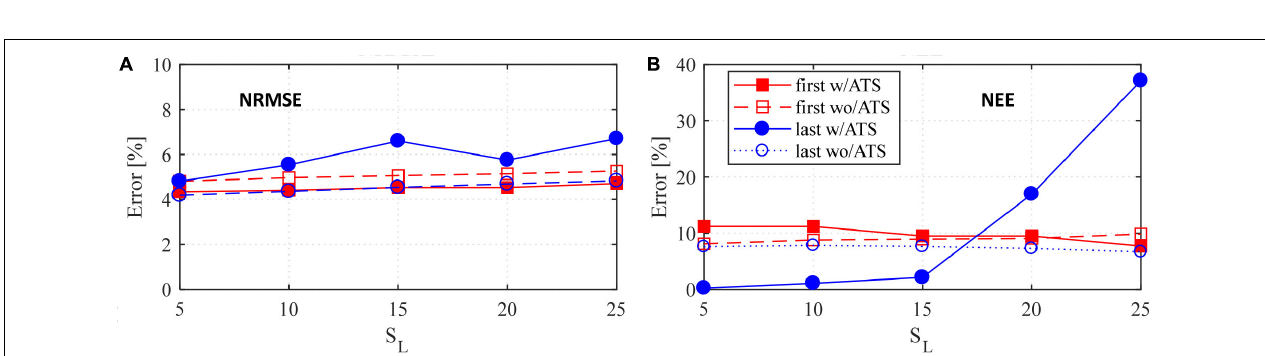
Frontiers in Built Environment |